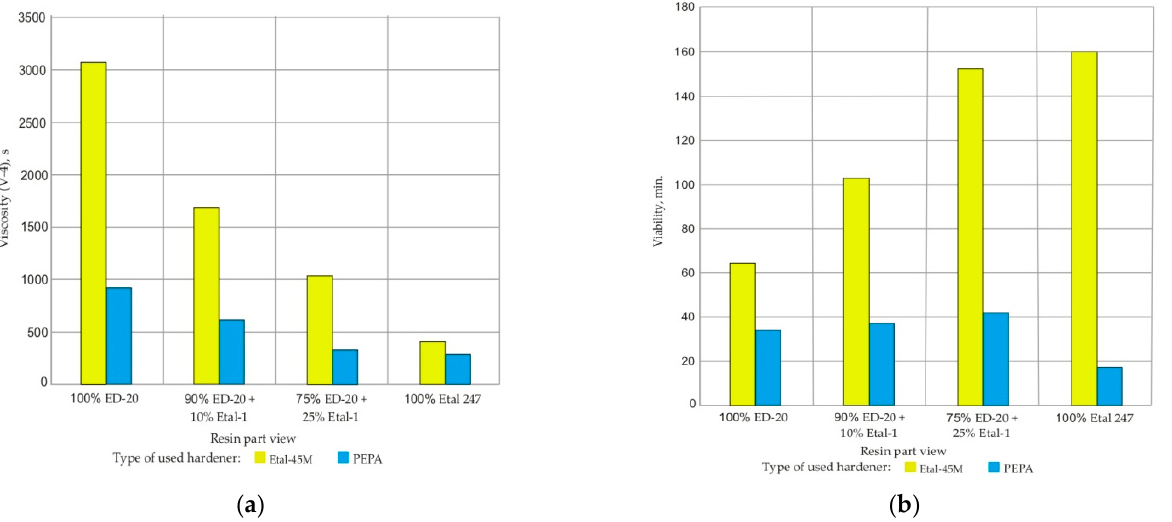
Figure 2. Viscosity ( a ) and pot life ( b ) of epoxy mixtures depending on the type of hardener used.